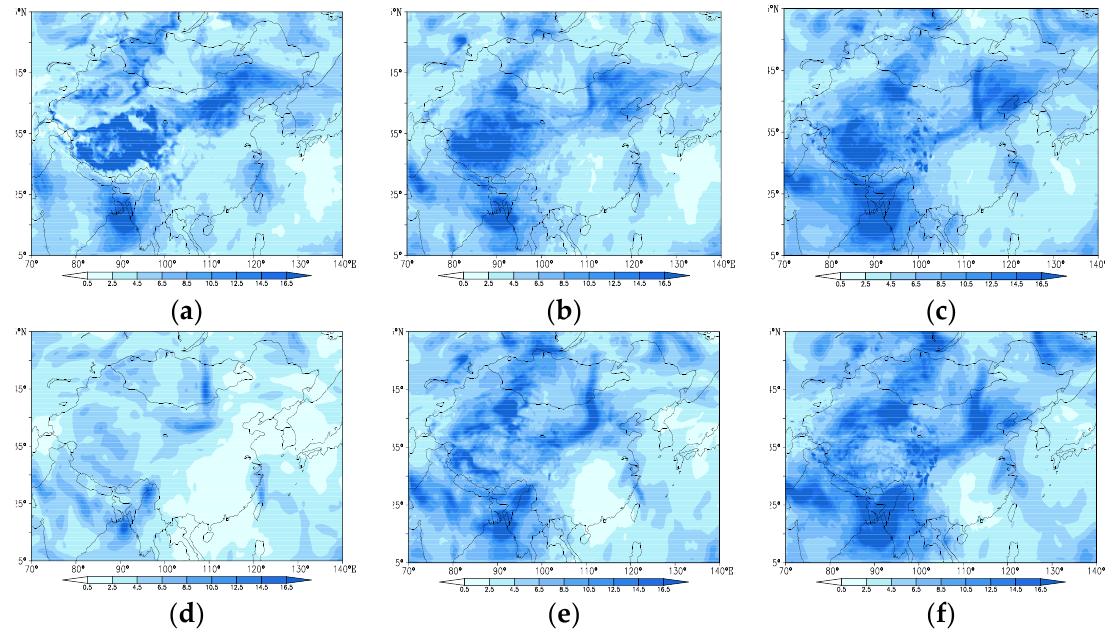
Figure 6. Horizontal distribution of zonal wind perturbation (shaded) and geopotential height (line) of the control analysis at 500 hPa; ETKF: ( a ) 00 h, ( b ) 06 h, ( c ) 12 h; ETKF-SS: ( d ) 00 h, ( e ) 06 h, ( f ) 12 h.